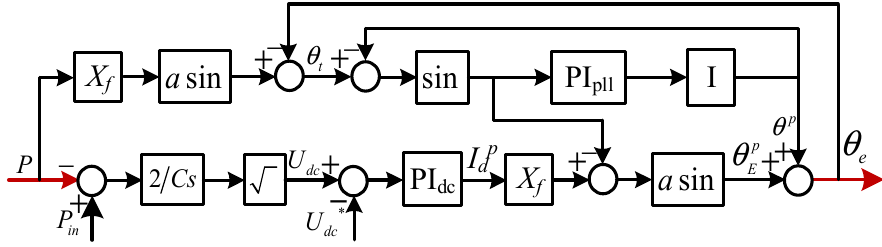
Figure 13. Open-loop phase dynamics with amplitude dynamics neglected. The nonlinear function has three types: sin, asin, and square root. The influence of nonlinear function on open-loop characteristics can be reflected by (23). The small increase in the amount of output relative to the small increase in the amount of input at different operating points at a disturbed trajectory is different. The complexity induced by nonlinearity has resulted from